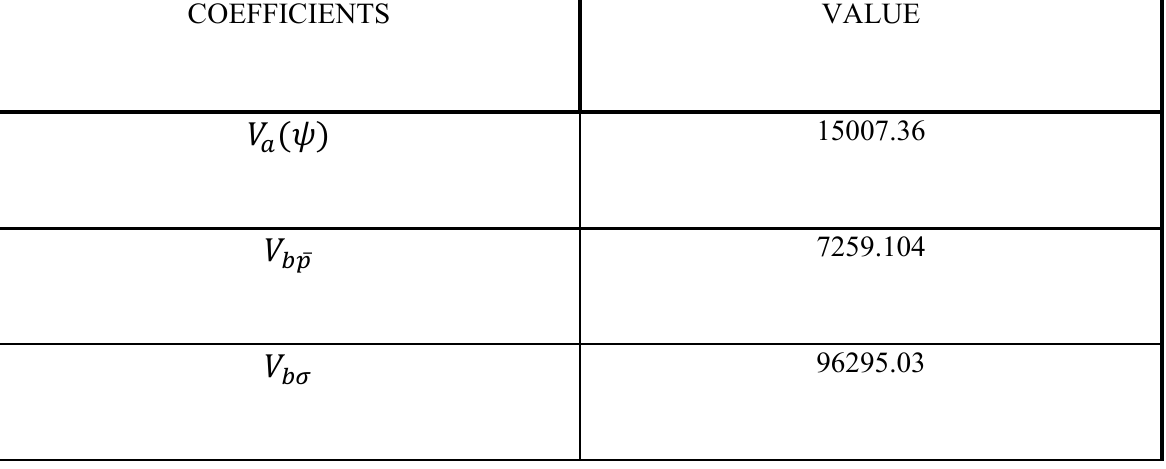
Table 2. Estimation Results of Optimal Hedge